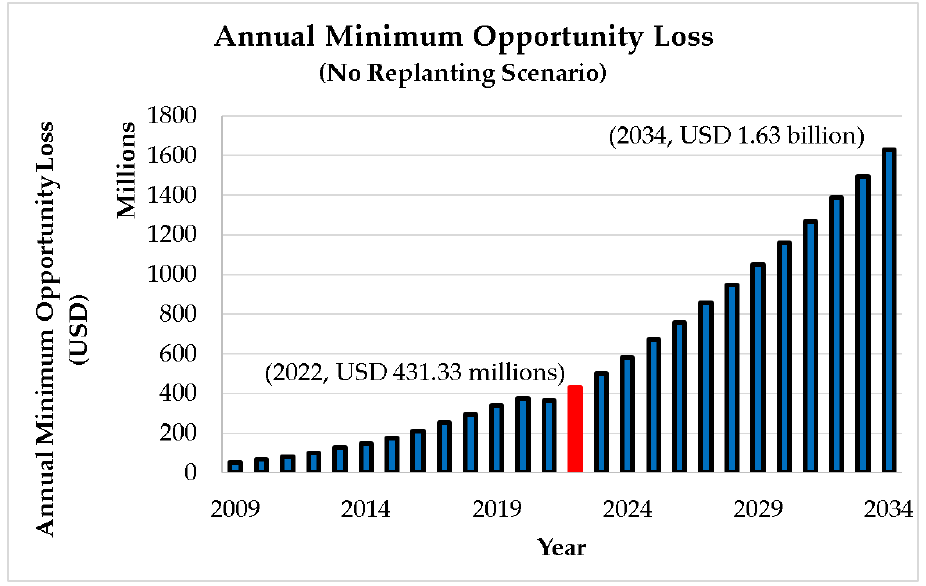
Figure 6. Minimum annual opportunity loss due to ageing of oil palm plantation (no replanting scenario).